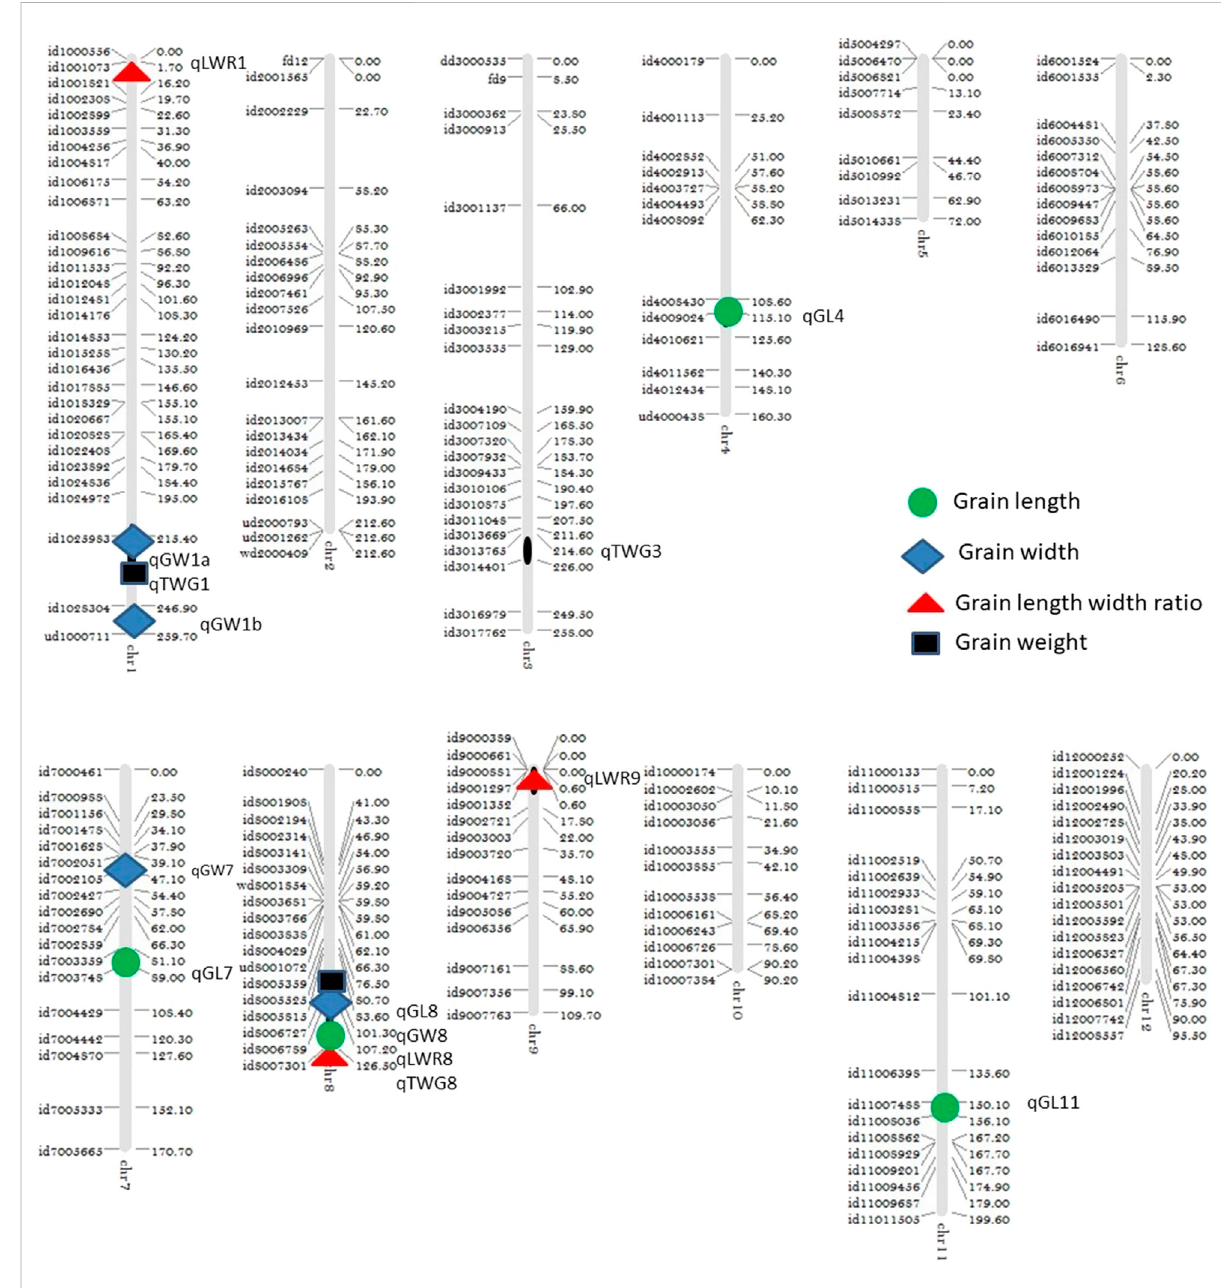
FIGURE 3 Linkage map showing the QTL location on